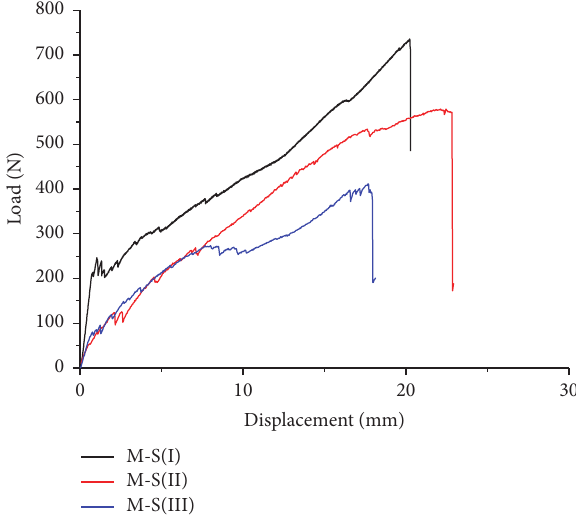
Figure 8: Load-displacement curves of specimens